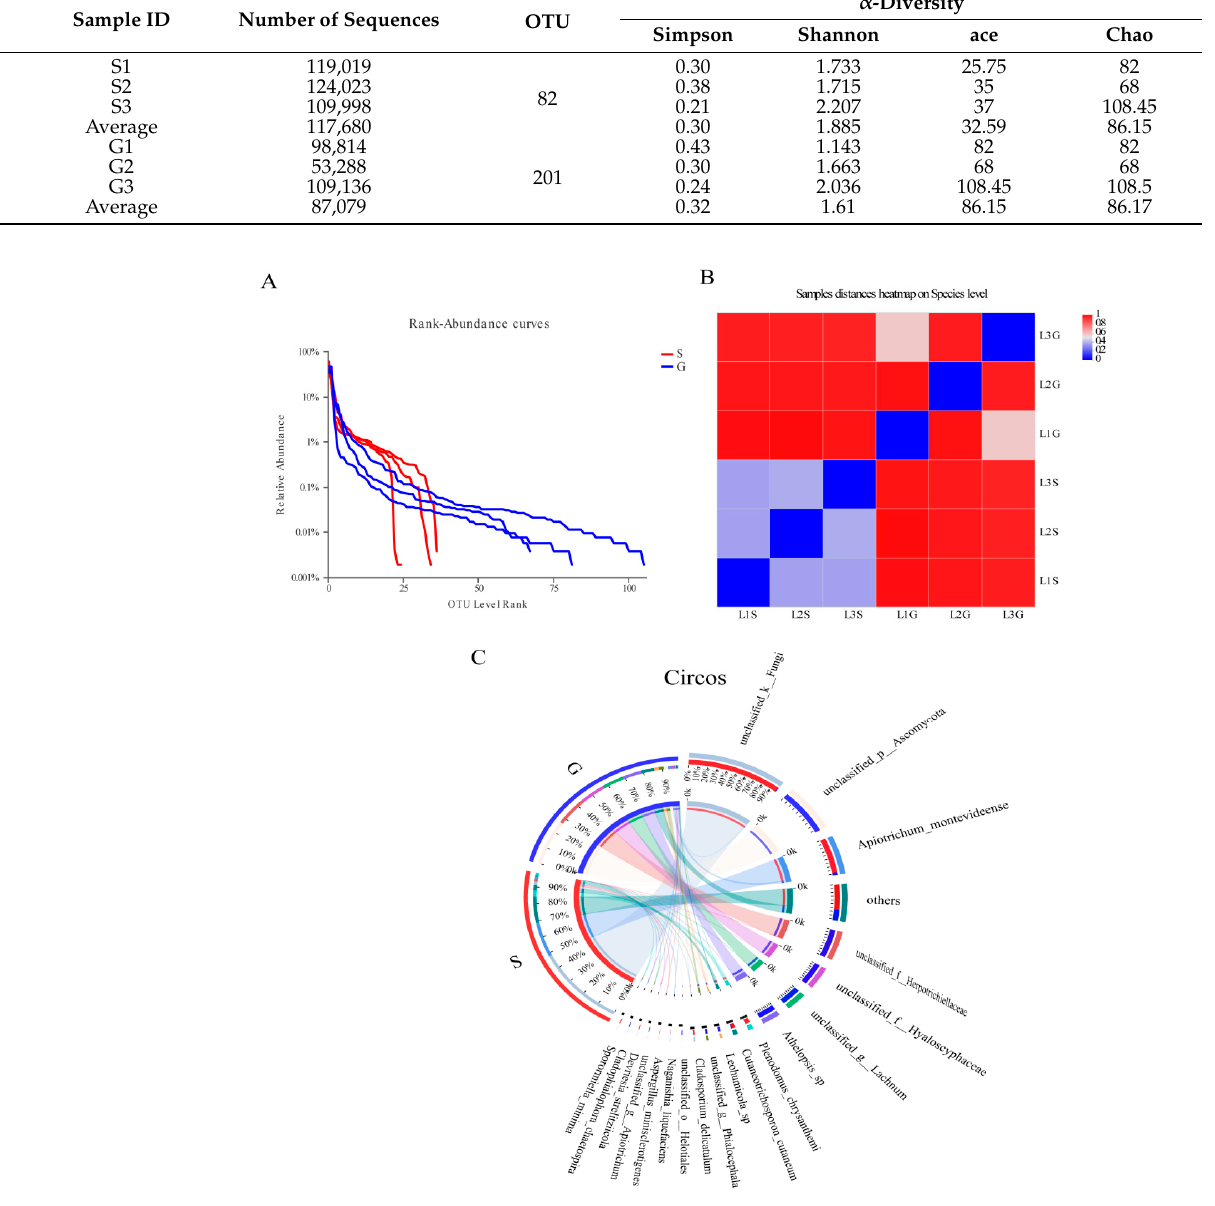
Figure 3. The diversity of culture-independent endophytic fungi between the shoot and root of S. chamaejasme. ( A ): The rank curve based on OTU abundance; ( B ): Beta diversity heatmap based on Unweighted UniFrace distance. Different color indicates difference in samples of species diversity; ( C ): Circos graph. The left semicircle represents the species composition of each group. The right semicircle indicates the distribution of each species in the different groups. S = Shoot; G = Root. The computational analysis of α -diversity estimated the richness and diversity of two plant tissues at OTU cut-offs of 0.03 distance units (Table 4). Among them, Chao1 and Ace estimated the minimum number of OTUs, and inverse Simpson and Shannon diversity index indicated the richness of the communities. It was found that the Chao1, Ace and Simpson diversity of shoots EF were lower than those of roots (with significant differ- ences, p < 0.05, for Chao1, Ace) (Table 4). However, the Shannon indices of shoots EF were higher than those of roots (no significant difference, p > 0.05). Beta diversity analysis indi- cated that endophytic fungal species diversity between the shoot and root was signifi- cantly different (Figure 3B), as was observed in the circos graph (Figure 3C) and heat map (Figure 4).